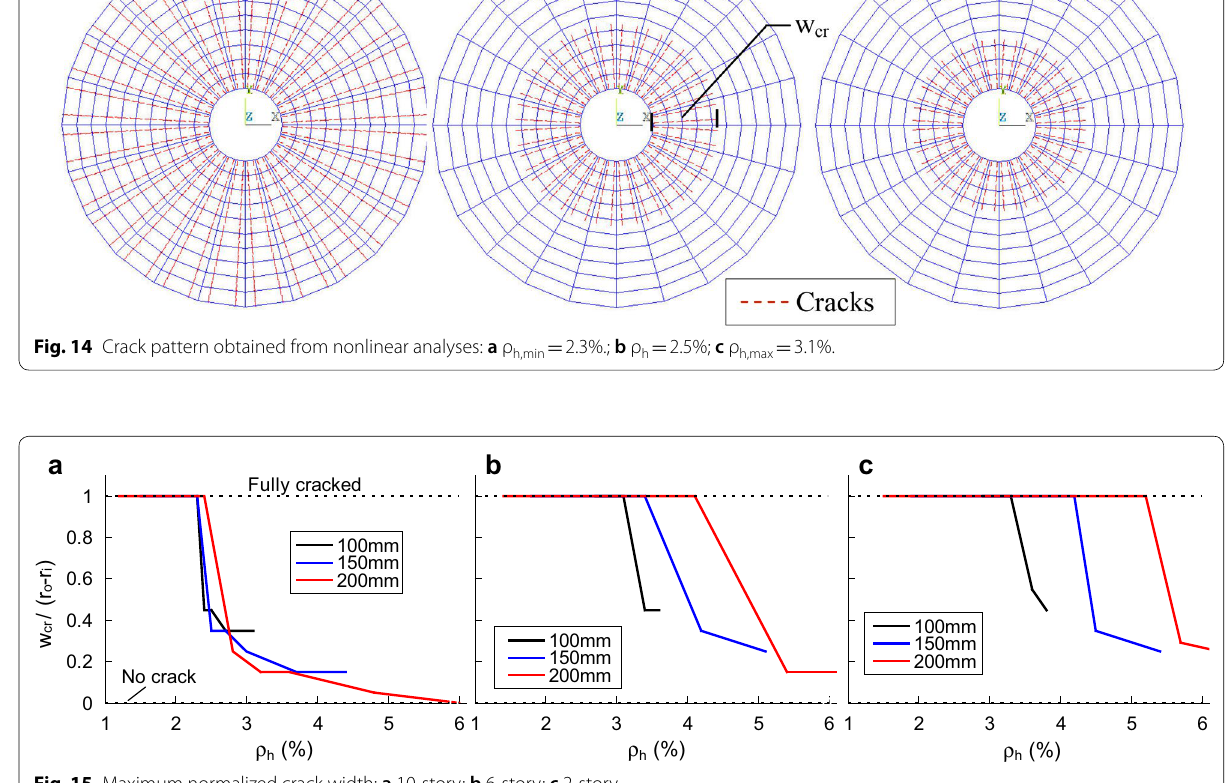
Fig. 15 Maximum normalized crack width: a 10-story; b 6-story; c